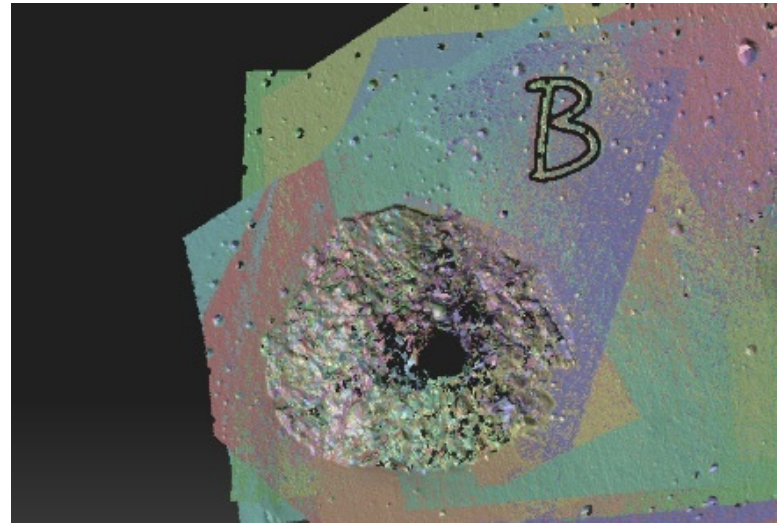
Crystals 2021 , 11 , x FOR PEER REVIEW